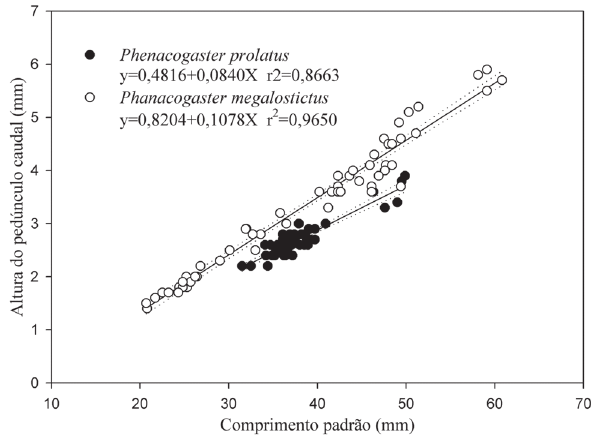
Figura 9. Regressão da altura do pedúnculo caudal em relação ao comprimento padrão de Phenacogaster prolatus e P. megalostictus